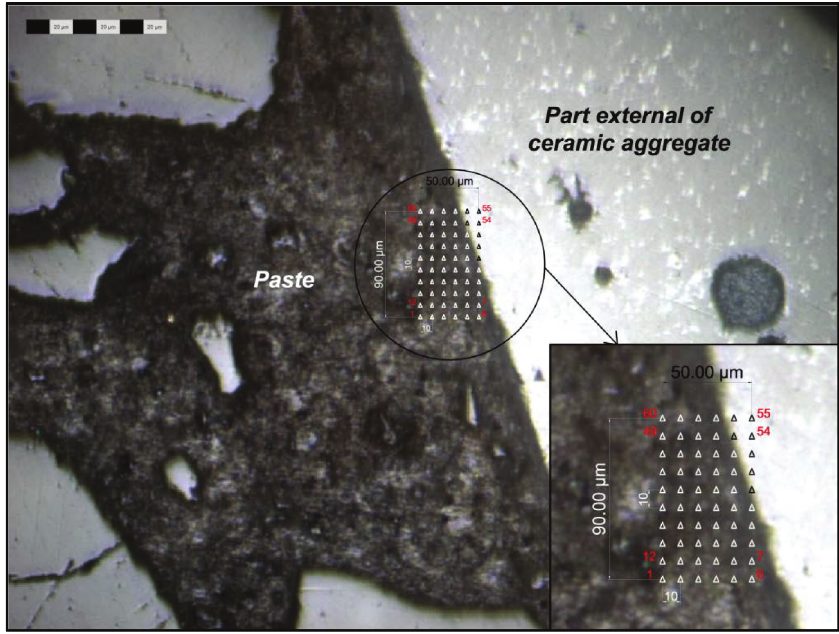
Fig. 5. BSE image of part external of ceramic aggregate interfacial transition zone, where the dimension of the indented area is 50×90 μm with an indent spacing of 10